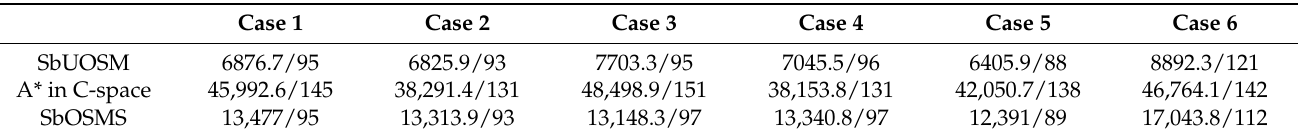
Table 2. Summary table of algorithm execution times/total planning steps for the three algorithms under the six cases (Unit: µ